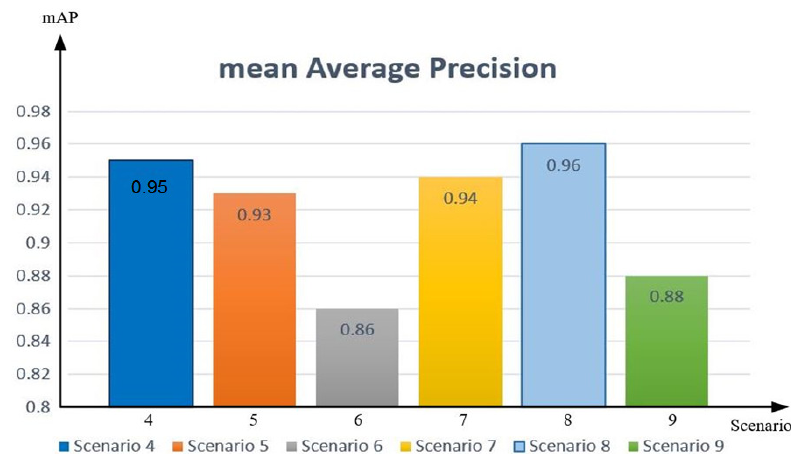
Figure 20. Measure of mAP for Scenarios 4 to